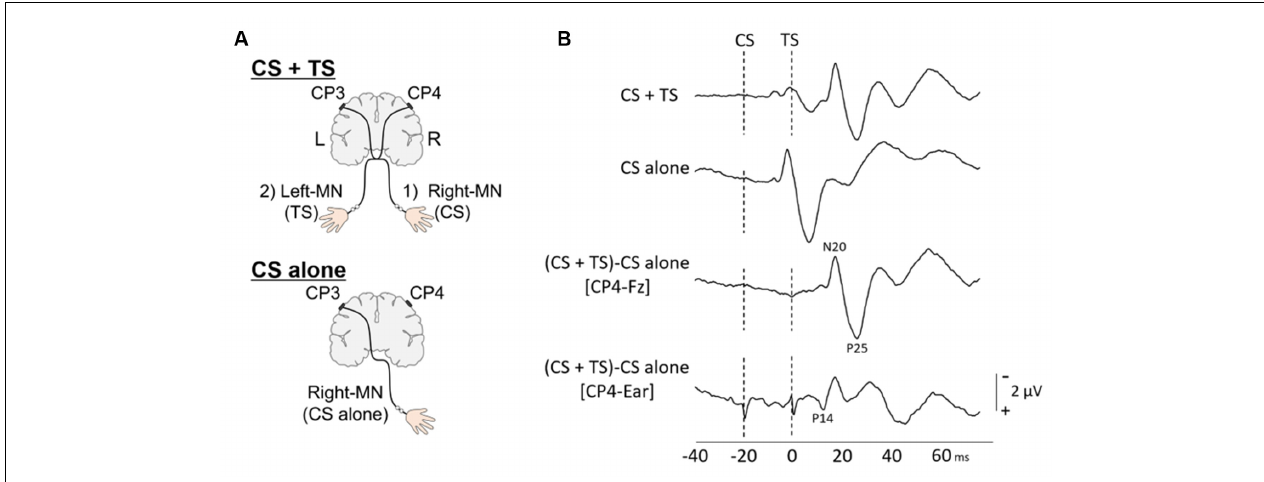
FIGURE 1 | Paired median nerve somatosensory evoked potential (p-SEP). (A) To investigate the effect of conditioning stimulus (CS) on the SEP induced by the test stimulus (TS) (upper panel), the paired median nerve SEPs (p-SEPs) and (lower panel) the single median nerve SEPs (s-SEPs) were recorded at CP4 electrodes. In the p-SEP recording: (1) the right median nerve (right-MN) stimulation as CS always preceded; (2) the left median nerve (Left-MN) stimulation as TS with nine different interstimulus intervals (ISIs; 1, 2, 3, 5, 10, 20, 40, 60, and 100 ms). (B) Typical p-SEP (ISI; 20 ms) and s-SEP waveforms at CP4 from a representative individual. Dotted line: the time of stimulation. The p-SEP data were analyzed using the following formula: p-SEPs = (SEP response of CS + TS at CP4) – (SEP response of CS alone at